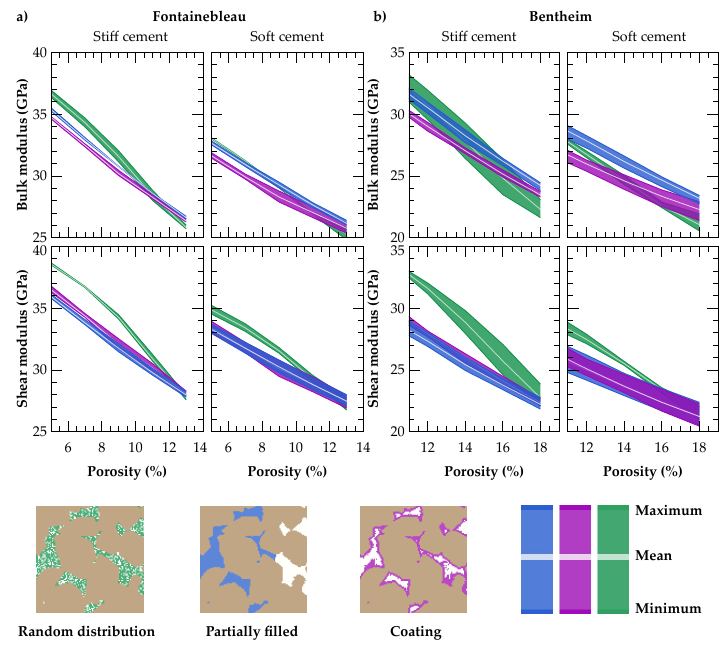
Figure 8. General trends of reduction in elastic properties due to calcite cement dissolution, considering stiff and soft cement moduli for the two investigated digital samples of ( a ) the Fontainebleau and the ( b ) Bentheim sandstones. The range for the three investigated spatial calcite distributions (green, blue, magenta) is based on the three selected representative sub-cubes and determined by their least